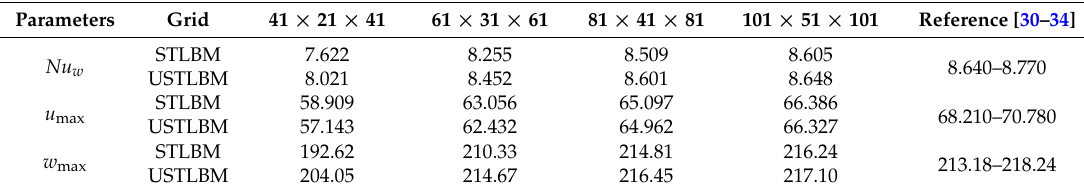
Table 8. Comparisons of flow parameters for 3D natural convection in Ra = 10 6 .